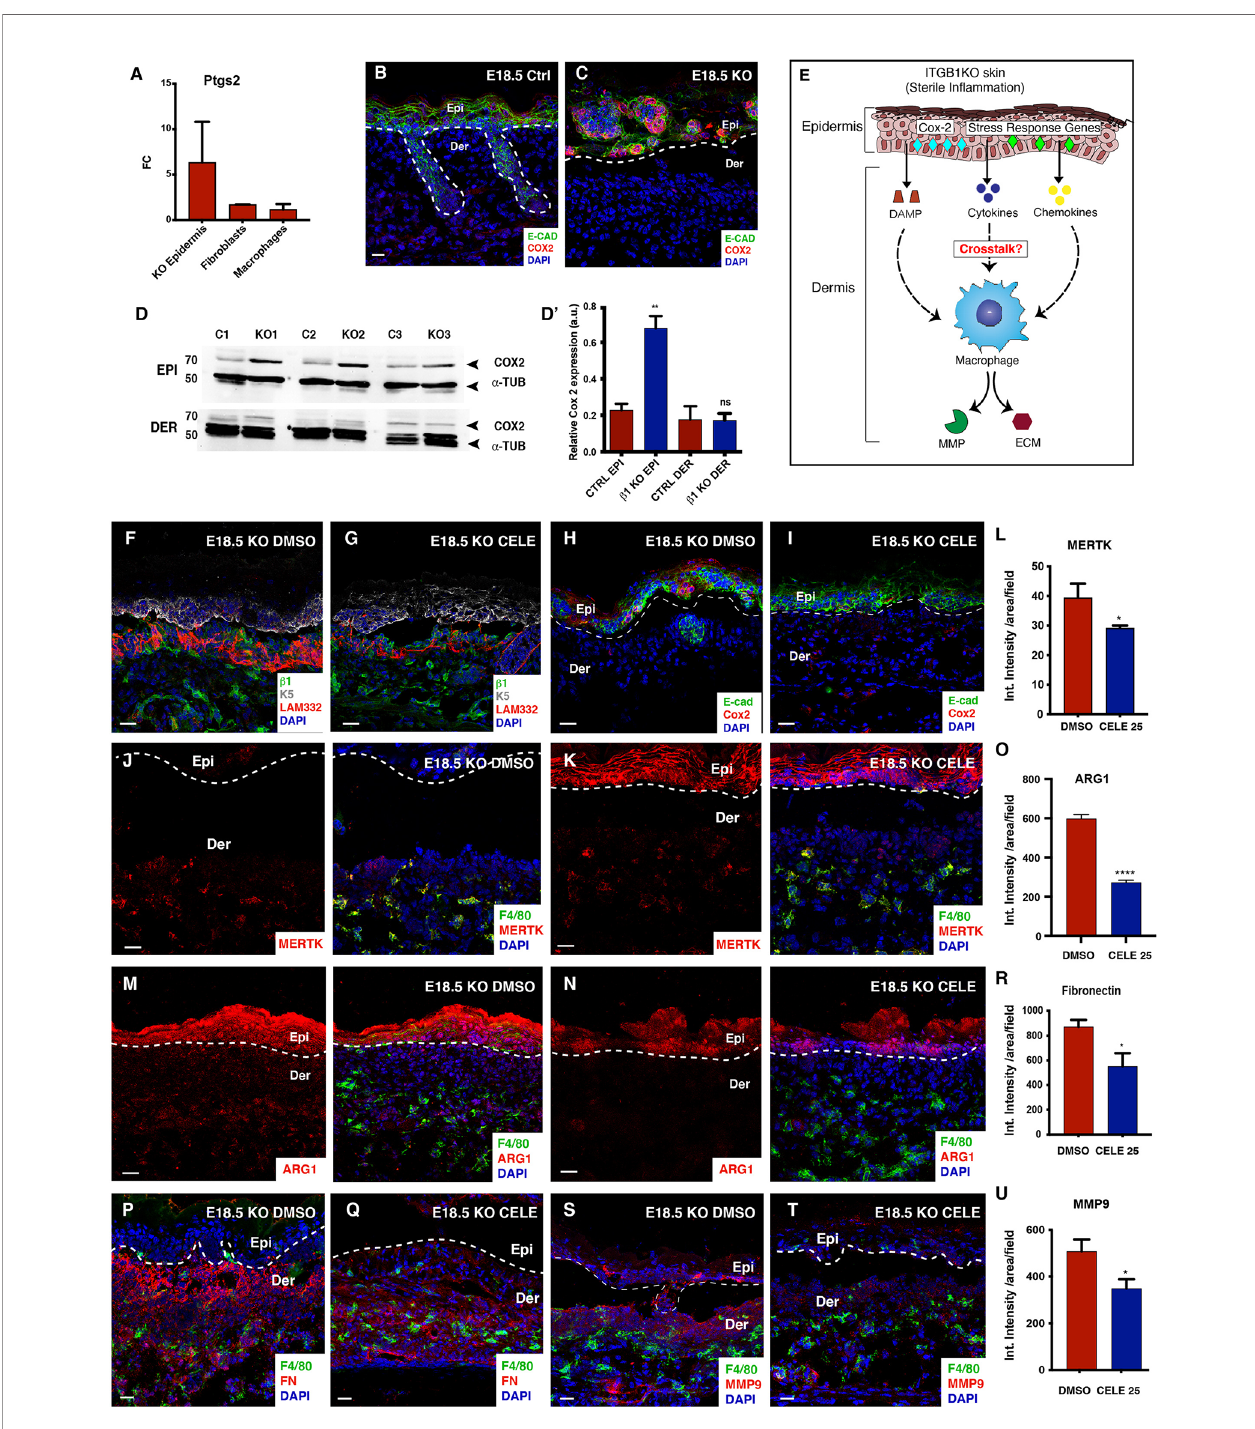
FIGURE 5 | Reduced BM remodeling and ECM abundance in the celecoxib treated E18.5 KO skin. Quanti fi cation of Ptgs2 transcript expression in the epidermis, fi broblasts and macrophages in the E18.5 Itg b 1 epidermal KO skin compared to the control (A) . Fold changes in the control are normalized to 1 (N=2). Immunostaining for COX2 and E-cadherin (Ecad) expression in the E18.5 control and the Itg b 1 epidermal KO skin (B, C) (N=2). Western blot of COX-2 in epidermis and dermis from Control and KO skin at E18.5 (D) which is quanti fi ed (D') . a -tubulin is used as endogenous control. 70 and 50 represent molecular weight of proteins in KDa. Graphical representation of COX-2 driven epithelial-macrophage crosstalk in the epidermal Itg b 1 KO skin (E) . Immunostaining in the E18.5 KO epidermis treated with DMSO and celecoxib for LAM332, Itg b 1, and Keratin 5 (K5) (F, G) ; COX2 and Ecad (H, I) (N=2). Immunostaining for F4/80 and MERTK (J, K) quanti fi ed by fl ow cytometry in (L) (N=3). Immunostaining for F4/80 and Arginase 1 (Arg1), (M, N) quanti fi ed in (O) . Immunostaining for F4/80 and Fn1 (P, Q) quanti fi ed in (R) . Immunostaining for F4/80 and MMP9 (S, T) quanti fi ed in (U) . The white dashed line separates the epidermis (Epi) and the dermis (Der). Scale bars: 20 µm. *p ≤ 0.05, **p ≤ 0.01, ****p ≤ 0.0001, ns, not signi fi